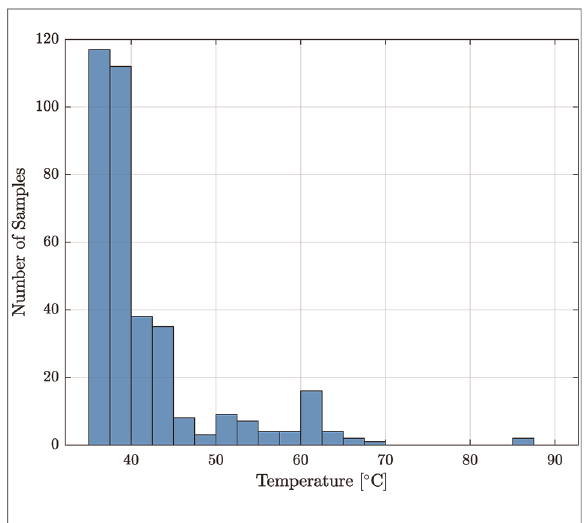
FIGURE 10 The distribution of temperatures at which the maximum hysteresis